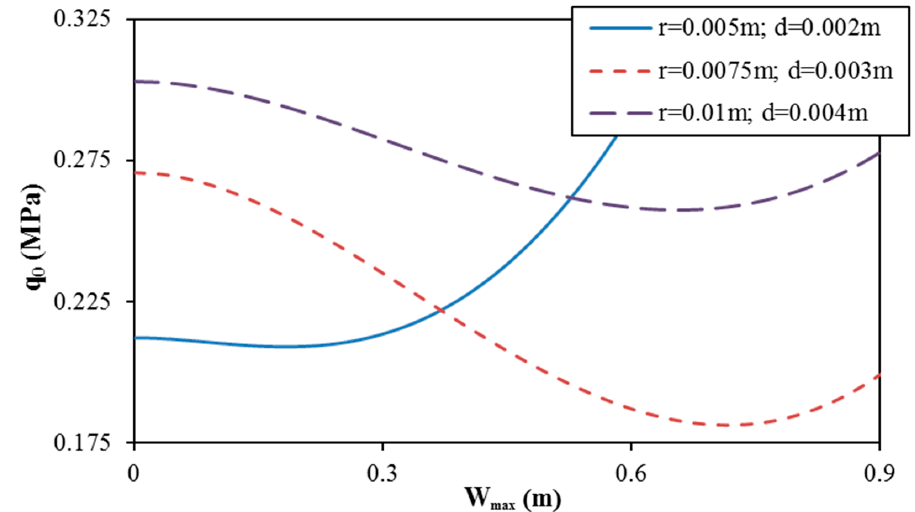
Figure 7. Effect of geometrical parameters of corrugation on the postbuckling curve of spiral corrugated UD-CNTRC cylindrical shells (round corrugation, V ∗